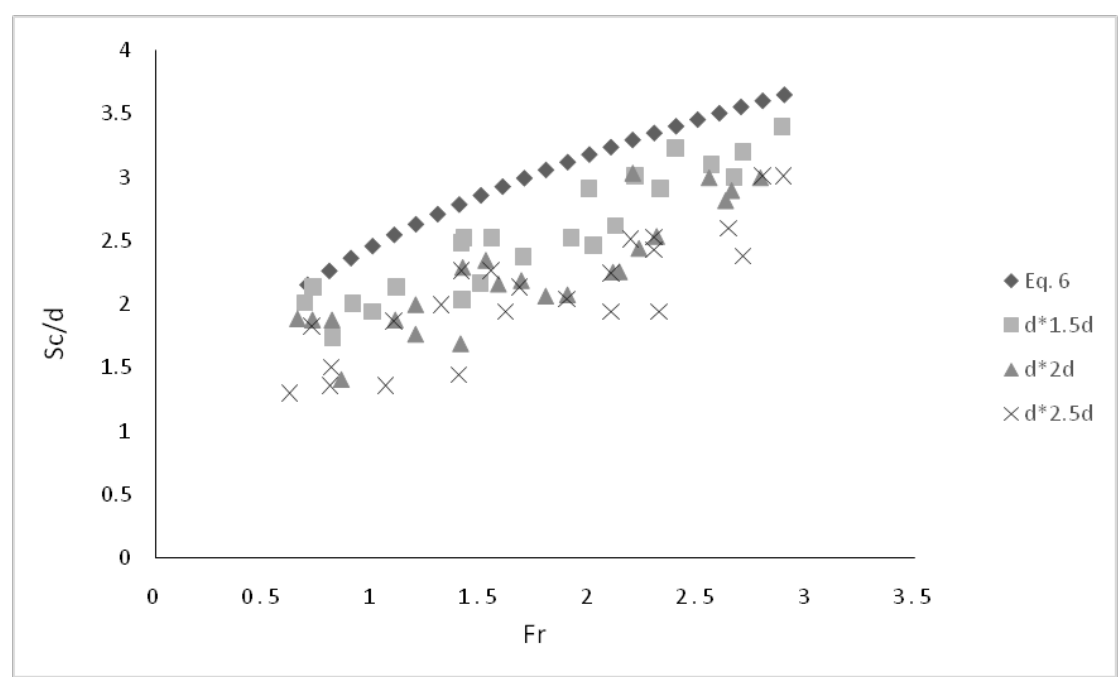
Fig. 9 The experimental results of the critical submergence at various Froude numbers. (Plates with height of